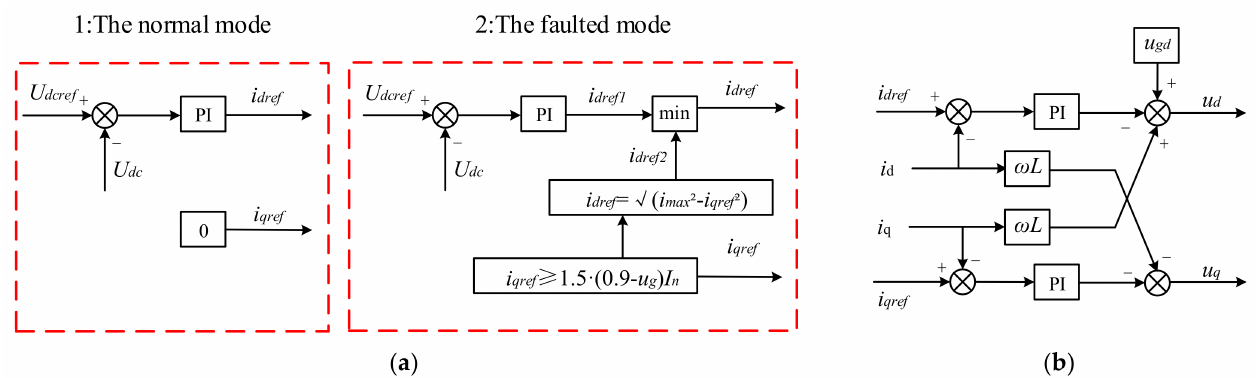
Figure 9. The control strategy of the grid-side converter (GSC): ( a ) the outer loop control and ( b ) the inner loop